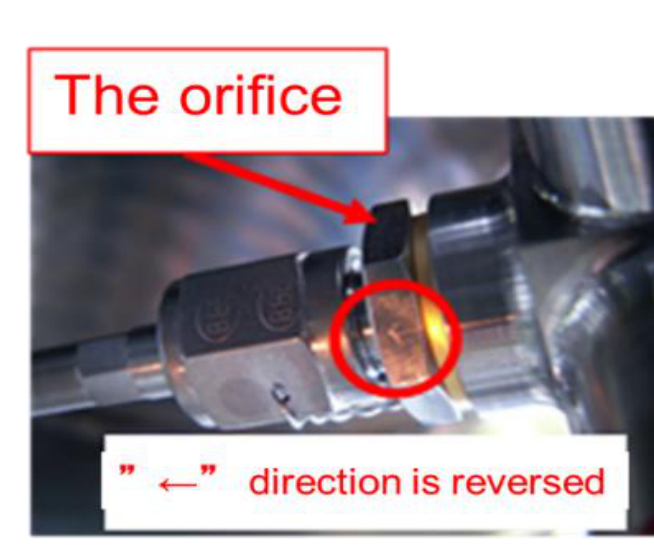
Figure 3. Orifice